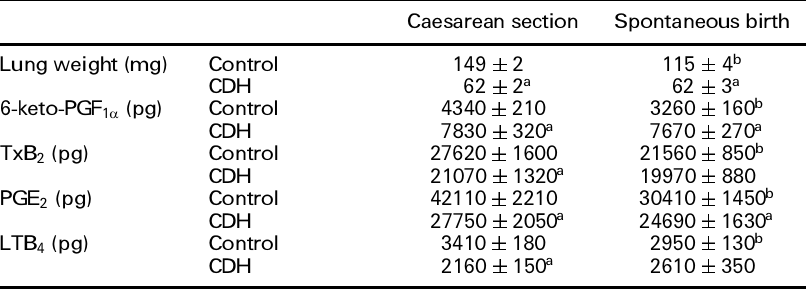
Table 1. Lung weights and total amount of eicosanoids in lung homogenates of controls and CDH pups after delivery by caesarean section or after spontaneous